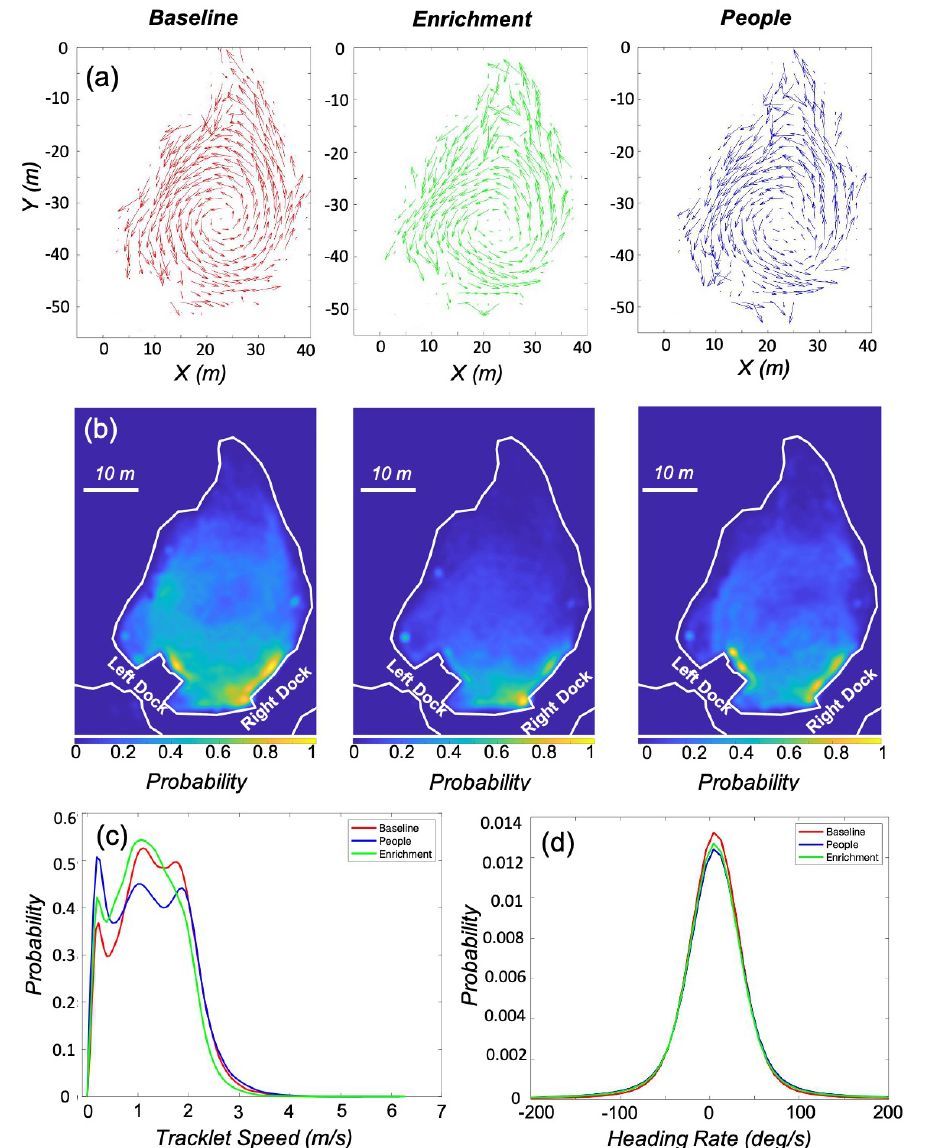
Figure 4. Results comparing the three environmental conditions: baseline, enrichment, and people. ( a ) Quiver plots for all three conditions show counter-clockwise movement in the lagoon, with the most concentric pattern occurring during the baseline condition. ( b ) Position heatmaps for the conditions show how the presence of enrichment or people modified where the animals spent time in the environment. ( c , d ) Probability density functions for the speed and heading rate of the animals derived from the tracklets. The animals tended to swim faster during the baseline condition, and spent more time stationary when people where present in the environment. Mean heading rates for all three conditions were positive, indicating counter-clockwise swimming